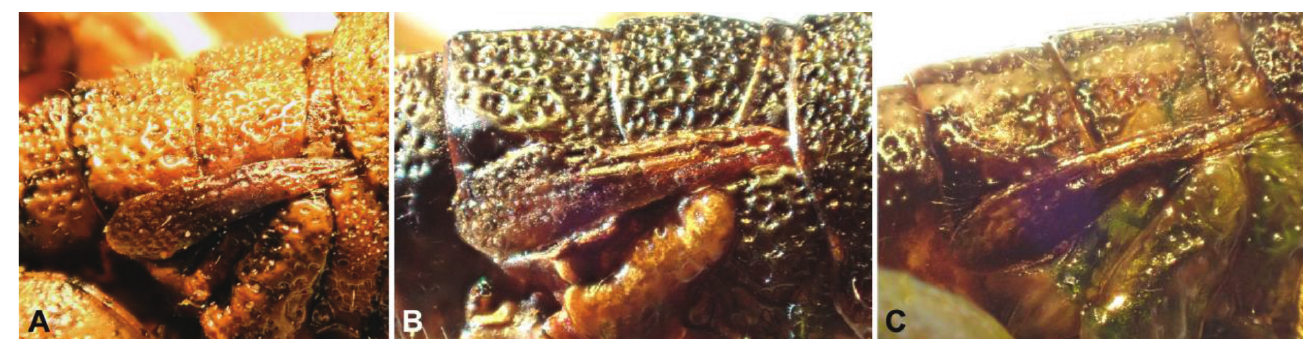
Fig. 3. Right tegmen of male Physocrobylus species. A. P. burtti ; B. P. tessa ; and C. P. venetus sp. nov.